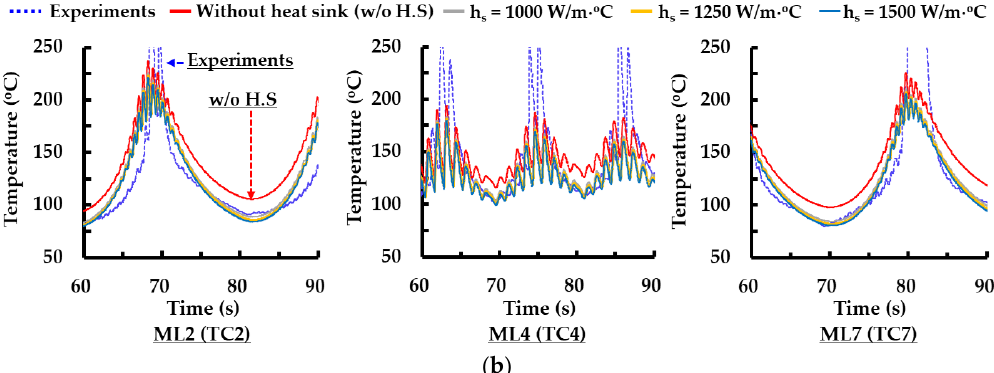
Figure 6. Comparison of temperature histories of experiments and those of FEAs for different coefficients of the heat sink (type 5 path of ADDSs): ( a ) temperature histories for all measured locations (from the first layer deposition to the 8th layer deposition); ( b ) detailed temperature histories for selected deposition times and measured locations (MLs).